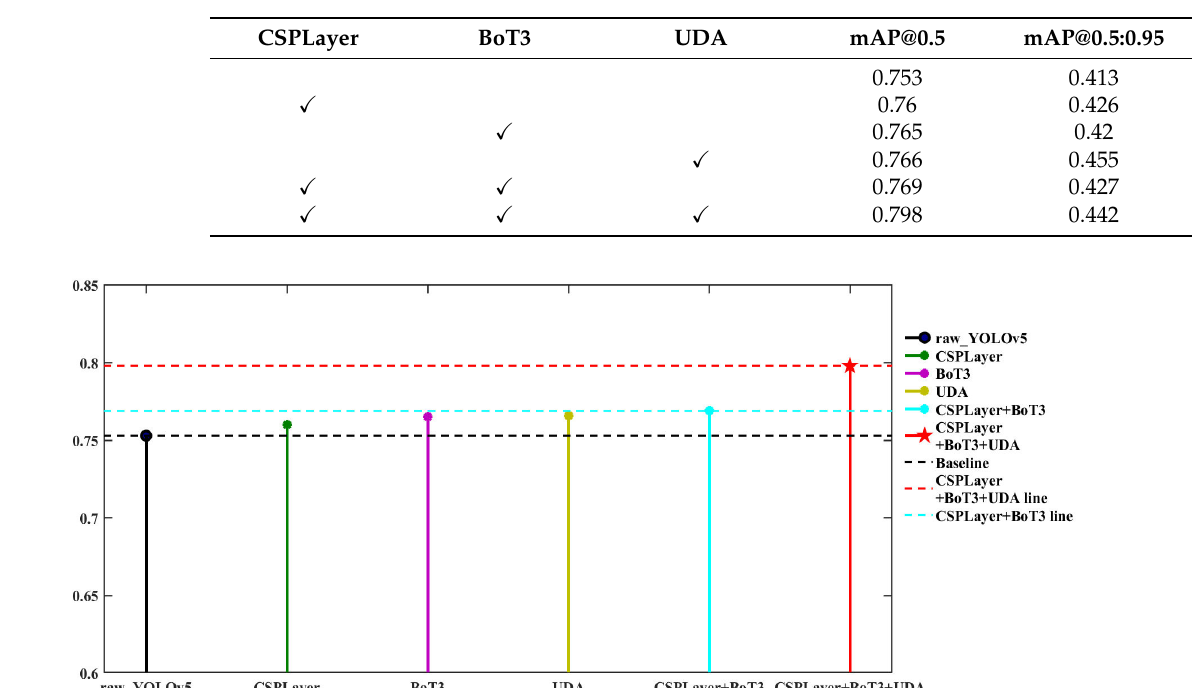
Table 1. Ablation Study on URPC2019.